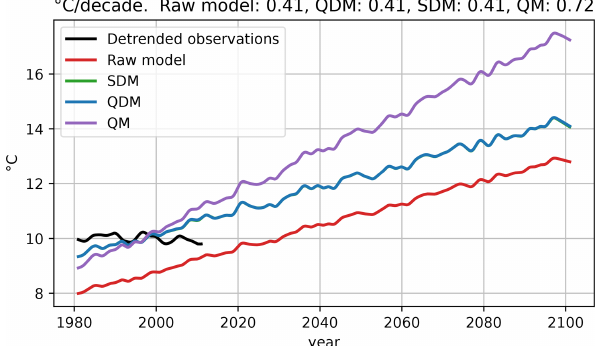
Figure 5. Running means of temperature data of detrended obser- vations, the raw model and three different bias-correcting methods (QM, SDM and QDM). SDM and QDM are almost identical. On top: average linear trends in ◦ C per decade (1981–2100) for each bias-adjustment method. The data are identical to the data used in Fig.